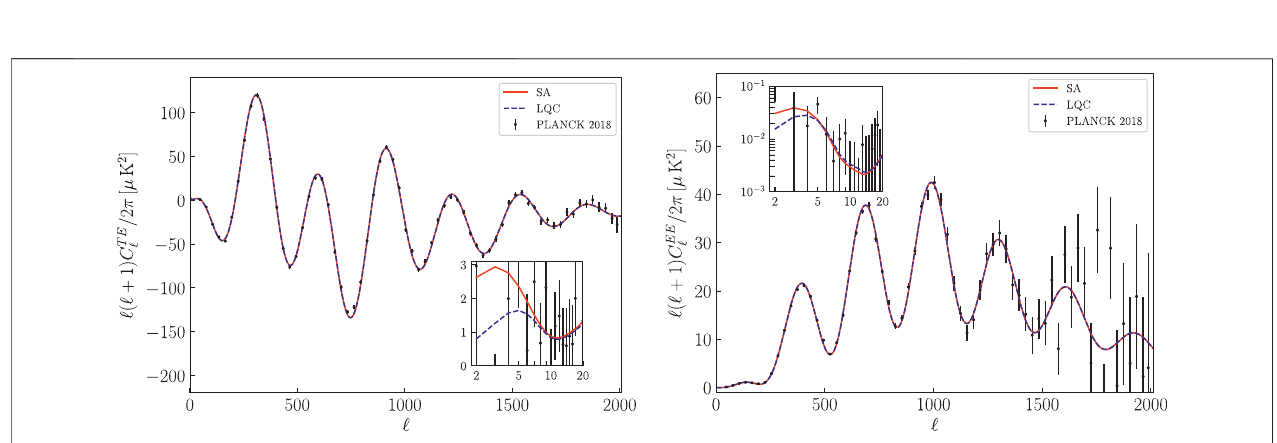
FIGURE 4 | Left Panel: The primordial power spectrum of LQC : The LQC suppression factor f ( k ) is less than 1 for k ( 10 k + x 3 . 6 × 10 − 3 Mpc − 1 for both the Starobinsky and quadratic potentials. At short wavelengths (large k ), or small angular scales, the LQC power spectrum is indistinguishable from the SA i.e. f ( k ) (cid:1) 1 for k ≫ k o . Right Panel: TT power spectra. The 2018PLANCKspectrum(black dots witherror bars), the LQC (dashed (blue) line) and thestandardansatz(SA) predictions (solid (red) line). As is usual, on the x -axis we have used a logarithmic scale for ℓ ≤ 50 and linear scale for ℓ > 50.